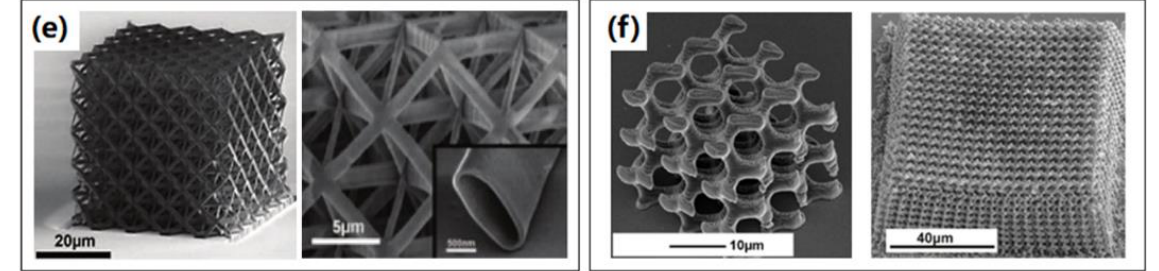
Figure 7. Resist polymer templates by EBL and DLW processes are used to fabricate various 3D nanostructures based on ALA method. ( a ) The illustrated process routine of 3D nanostructures based on electron resist templates through EBL technique. ( b ) SEM and optical images of the fabricated metalens. Reprinted with permission from Ref. [53], Copyright 2016 American Association for the Advancement of Science. ( c ) SEM images of the tree-shaped irregular nanostructures and nanotubes with ultra-high aspect ratio of more than 80:1, based on ALA method through electron resist templates by EBL technique. Reprinted with permission from Ref. [54], Copyright 2021 Elsevier. ( d ) The illustrated process routine of 3D nanostructures based on photoresist templates by DLW technique using ALA method. ( e ) Overall and enlarged SEM images of the overall alumina octet-truss nanolattice through photoresist by DLW technique based on ALA method. Reprinted with permission from Ref. [57], Copyright 2014 American Association for the Advancement of Science. ( f ) SEM images of two kinds gyroid photonic crystals through photoresist by DLW technique based on ALA method. Reprinted with permission from Ref. [58], Copyright 2016 American Chemical Society.